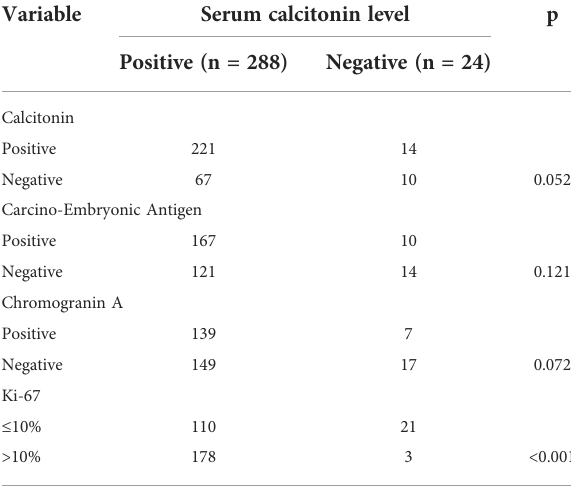
TABLE 2 Comparison of immunohistochemistry variables between negative and positive groups.